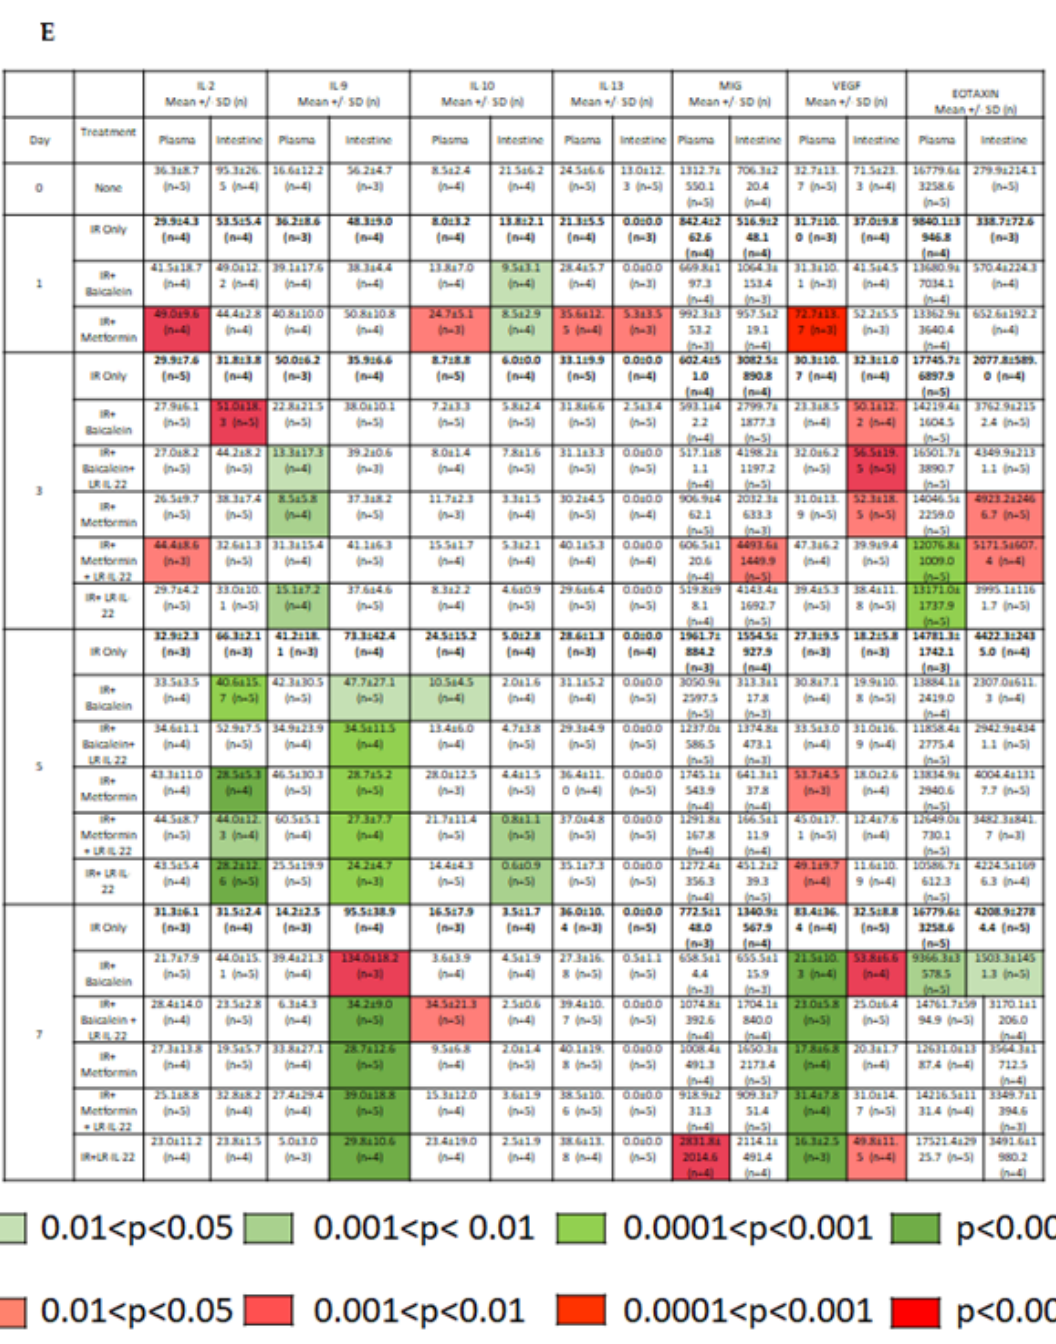
Figure 3. LR-IL-22 modulates irradiation induction of inflammatory cytokine and stress response gene proteins in the intestine and plasma after 15.75 Gy WAI. Six groups of C57 BL/6NTac mice (n = 4–5) were irradiated to 15.75 Gy WAI. The groups included: ( 1 ) irradiation only, ( 2 ) mice gavaged with 10 9 copies of LR-IL-22 in 100 µ L of saline only; ( 3 ) metformin only, ( 4 ) baicalein only, ( 5 ) LR-IL-22 with metformin, and ( 6 ) LR-IL-22 with baicalein. Control mice received no irradiation. Mice received LR-IL-22 gavage 24 h following WAI. Mice treated with metformin (60 nM) received drinking water for 7 days following WAI. Mice treated with baicalein (50 mg/kg) received the drug IM 15 min prior to WAI and 24 h after irradiation. Relative levels of expression of each protein ware based in the level detected in the irradiation only group on that same respective day 0, 1, 3, 5, or 7 after irradiation are shown for plasma and intestine panels ( A – E ) .